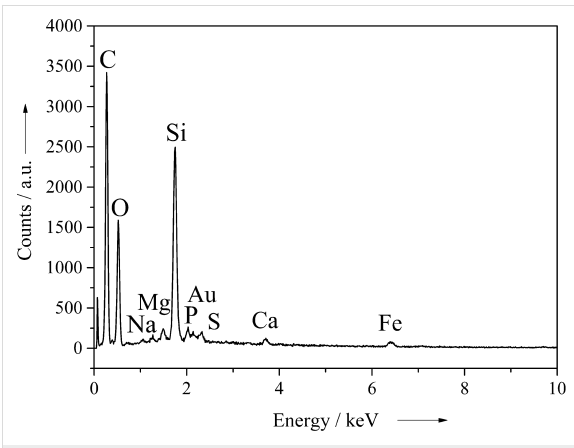
Figure 4: EDX analysis of golden algae ( Synura petersenii ) before the conversion.